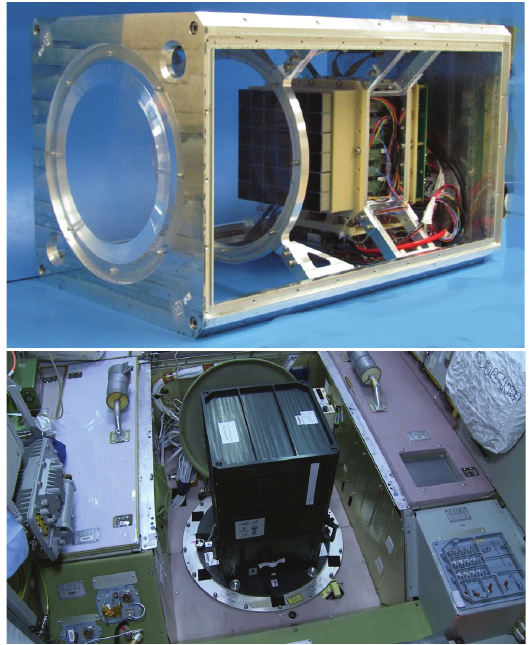
Figure 7. Top: open MINI-EUSO instrument, showing the cir- cular Fresnel lens, as well as the second generation PDM and its electronics at the focal surface. Bottom: MINI-EUSO locked onto the UV transparent window of the Zvezda module in the